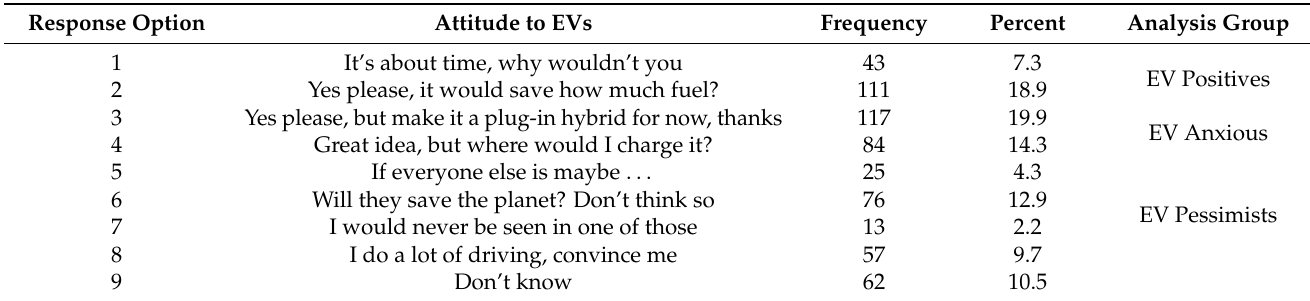
Table 3. ICEV motorists—attitudes to EVs from YouGov survey question A16 ( n = 588). Response